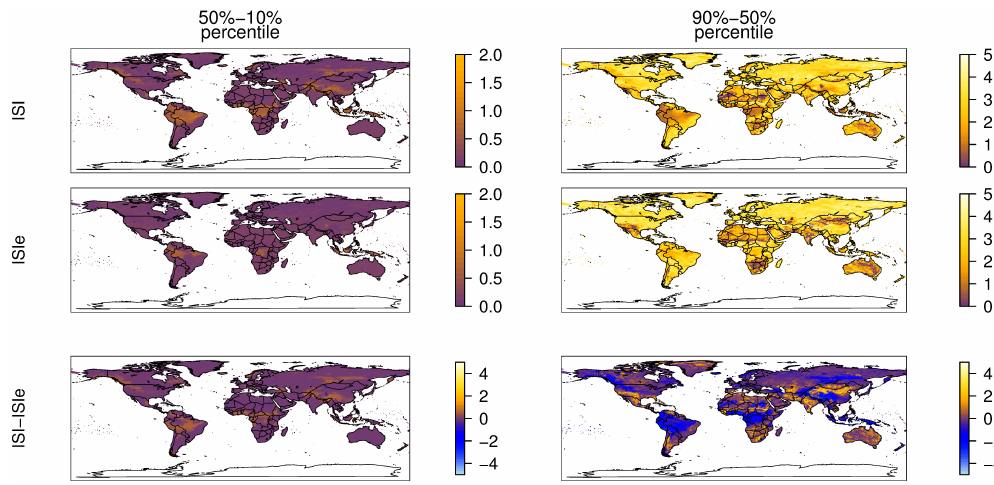
Fig. 11. The lower inter-percentile range (50–10%) and upper inter-percentile range (90–50%) of the normalised April daily precipitation from 2091 to 2099 are shown for the ISI-MIP dataset (ISI) and with the extended version of the algorithm (ISIe). In addition the differences of both version are shown. The inter-percentile ranges are analogues to Fig.